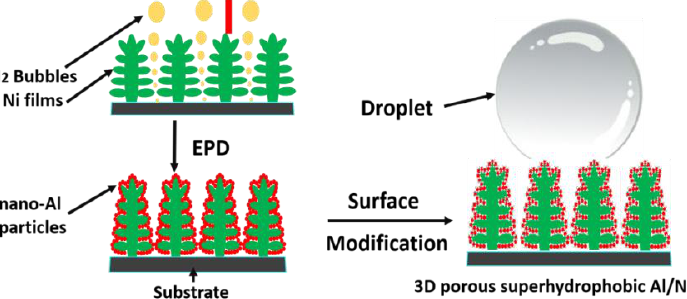
Figure 4. The schematic diagram of the synthesis process for 3D porous superhydrophobic Al/Ni EMs [69]. Copyright 2016, Applied Surface Science.